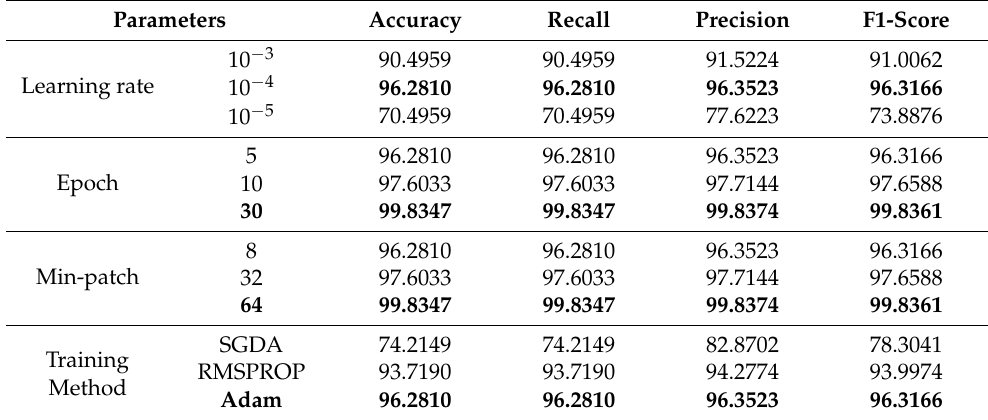
Table 2. Measures of 1D-CNN model for noisy LFM signals.